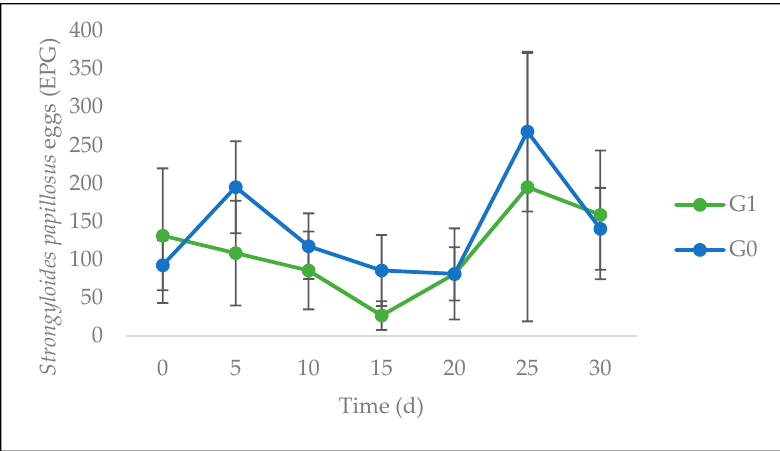
Figure 6. Evolution of Strongyloides papillosus eggs per gram of feces (EPG) of sheep fed on C. nlemfuensis hay alone (G0) or G. ulmifolia foliage and C. nlemfuensis hay (G1). d: day.